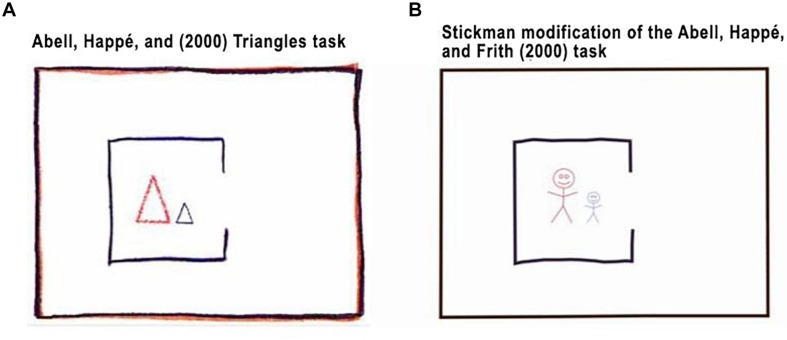
Comparison of the figures used in our experiments. Panel (A) shows the figures used in the original Abell et al. (2000) triangles task. Panel (B) shows our modified figures.